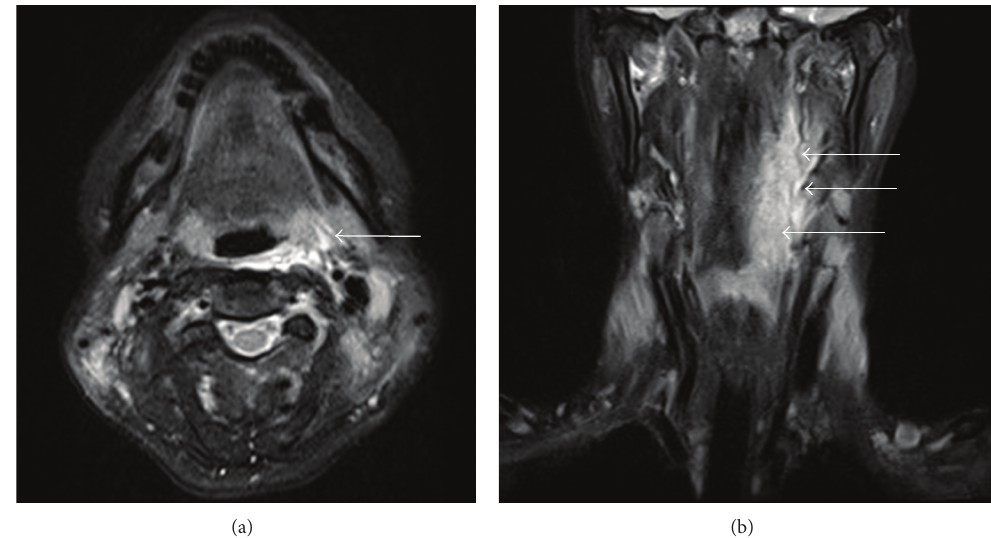
Figure 1: MRI of the neck: (a) T2WI axial section and (b) T2WI coronal section T2 hyperintensities are observed in the bilateral neck muscles, predominantly in the left pharyngeal constrictor muscles (arrows).